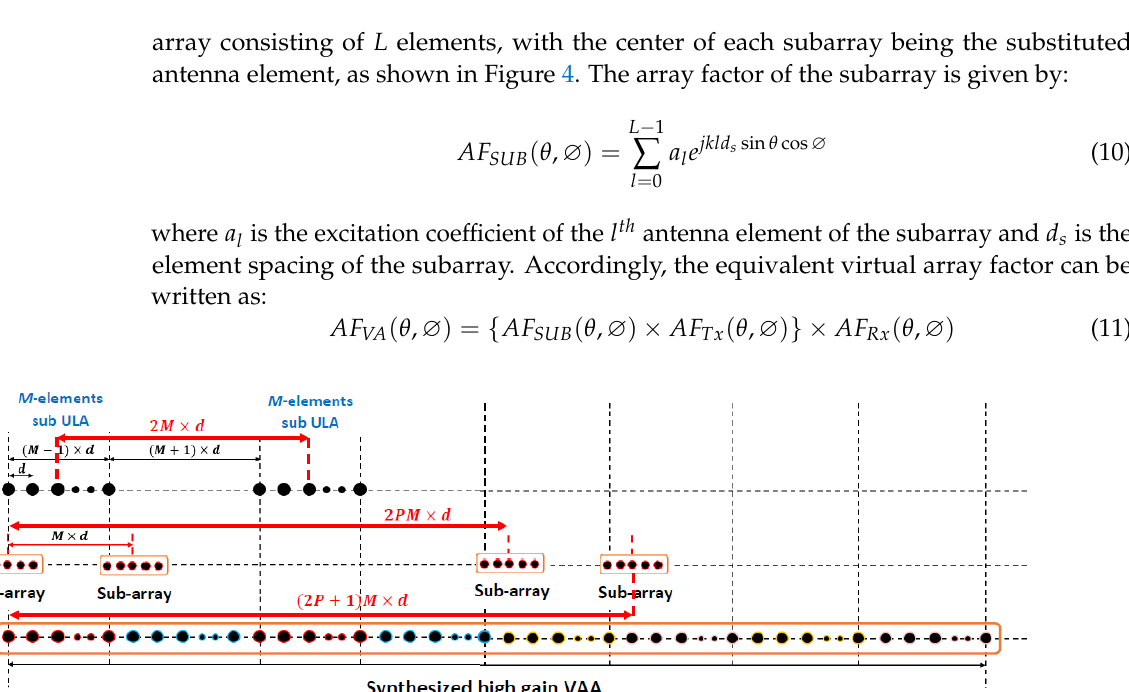
Figure 3. The synthesized 𝑁 = 40 -element VAA pattern for 𝑀 = 5 , 𝑄 = 2 , 𝑃 = 2 , and 𝑑 = 𝜆 2⁄